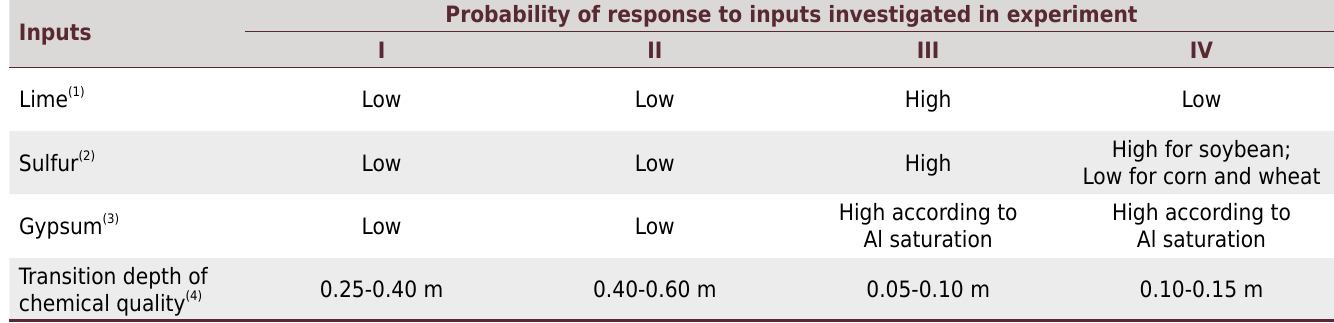
Table 4. Response probability classes of liming, gypsum, and sulfur for the four experiments and depth of transition of chemical quality Probability of response to inputs investigated in Inputs